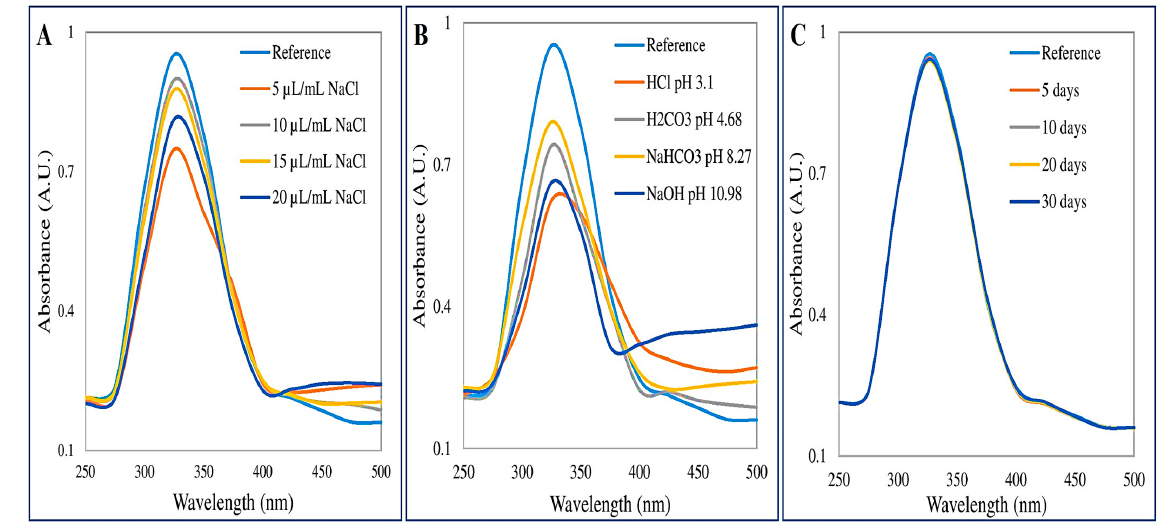
Figure 5. Stability analysis of calcium oxide nanoparticles with varying salinity ( A ); varying pH ( B ); passage of time ( C ).